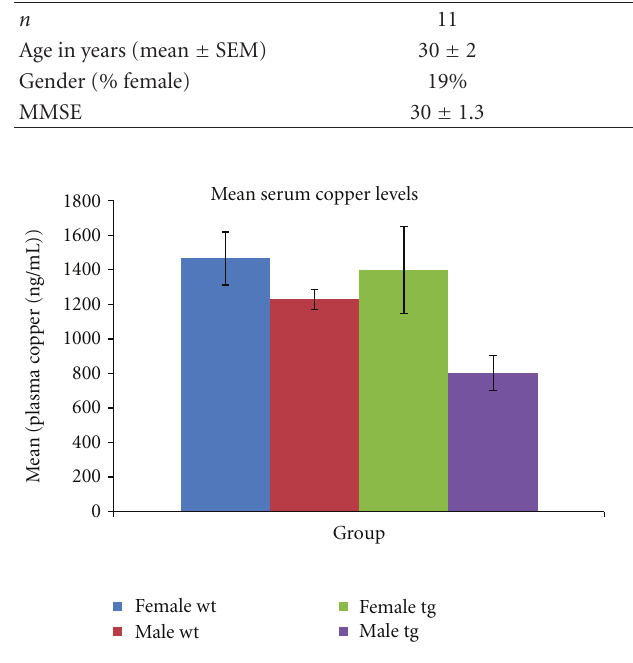
Figure 1: Serum copper levels (mean ± SEM) in triple transgenic (tg) and wild-type (wt) mice. Trends to higher serum copper in females are evident in both strains ( P = 0 . 06 for female tg versus male tg; P = 0 . 19 for female wt versus male wt. n = 7 female wt, 4 male wt, 7 female tg, 3 male tg).